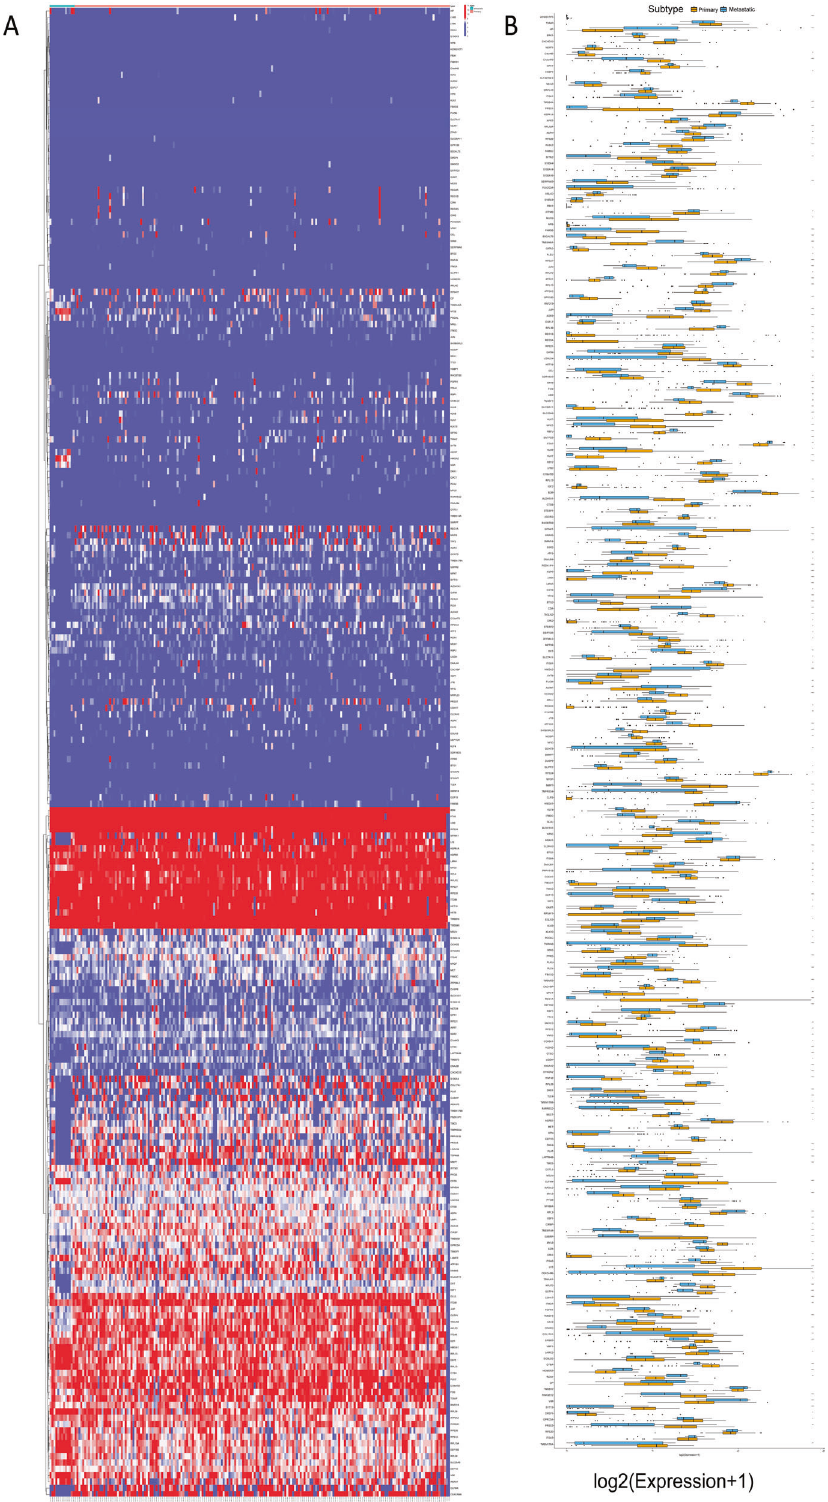
Fig. 8 Expression pro fi ling of metastatic-related genes in primary/metastatic tumor samples. A Heatmap of metastatic-related genes was drawn to reveal different distribution of expression states, where the colors of red to blue represented alterations from high expression to low expression. B Comparison of the expression level of metastatic-related genes between primary and metastatic cancer